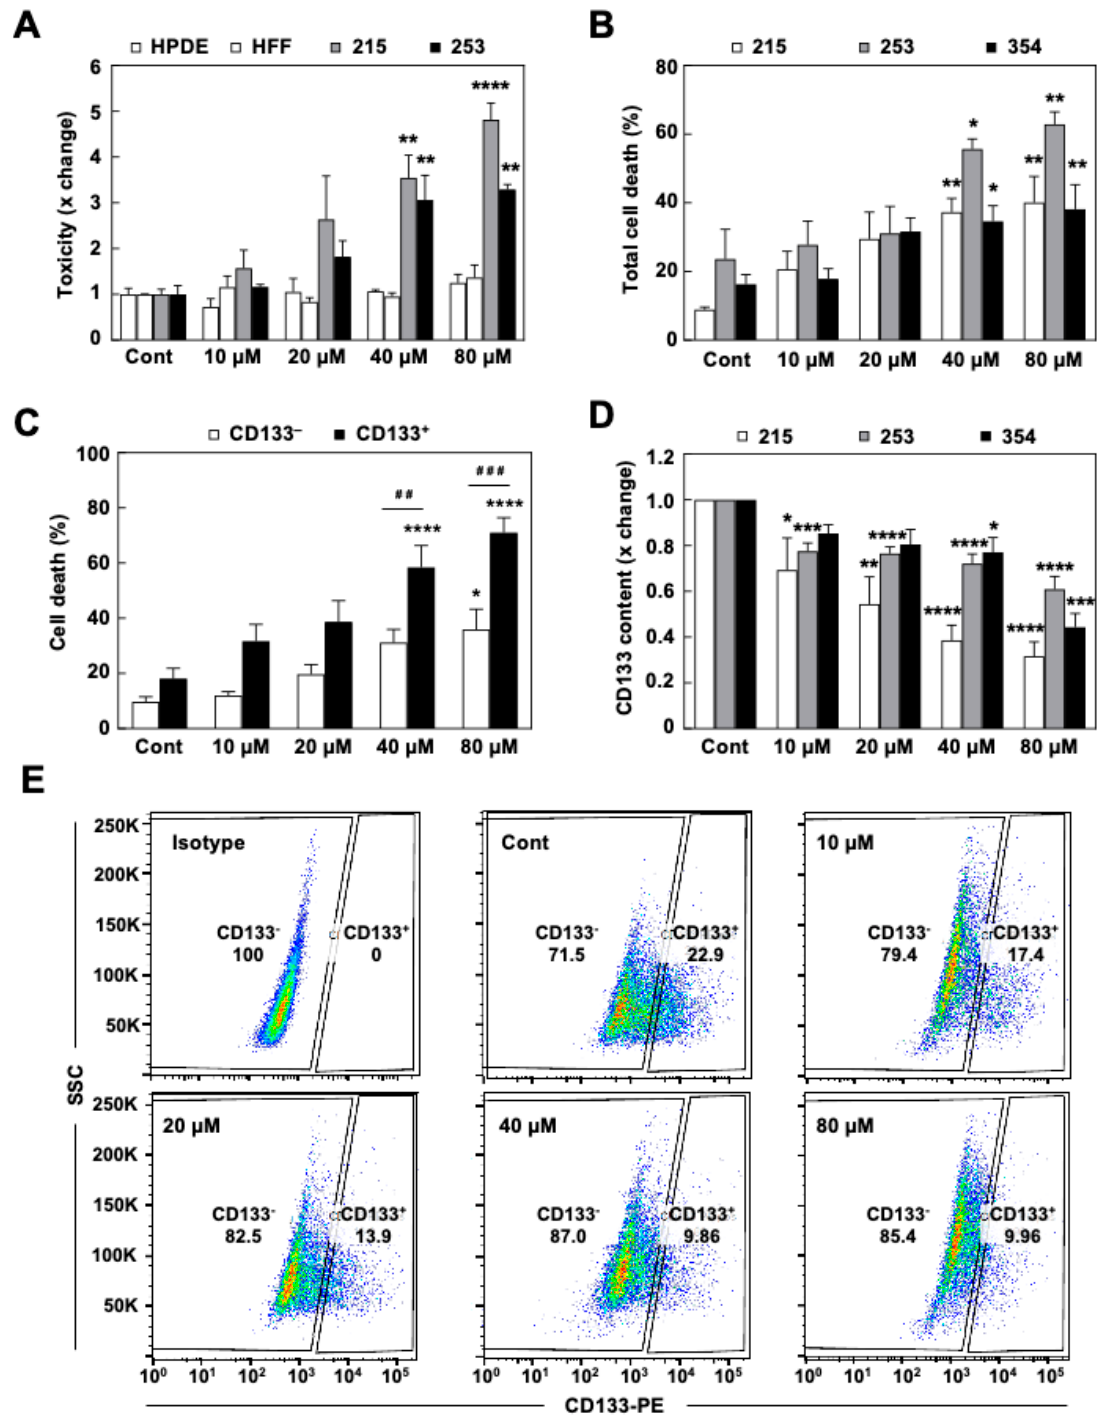
Figure 2. mDivi-1 treatment targets PDAC cancer cells and induces apoptosis in CSCs. ( A ) Cytotoxicity assay in response to mDivi-1 treatment for 72 h using 215 and 253 PDAC cells, non-transformed human pancreatic ductal epithelial cells (HPDE), and human foreskin fibroblasts (HFF). ( B , C ) Total cell death for different PDAC models after 72 h of mDivi-1 treatment, calculated for the entire cancer cell population ( B ) or for CD133 − and CD133 + cells ( C ) after staining for Annexin V-APC and Zombie Violet. ( D ) CD133 content in response to mDivi-1 treatment for 72 h, as evaluated by flow cytometric analysis in three different PDAC models. ( E ) Representative experiment in 253 cells from ( D ) * p < 0.05, ** p < 0.01, *** p < 0.001, **** p < 0.0001 vs. Control; ## p < 0.01, ### p < 0.001 vs. CD133 − cells; ANOVA with Bonferroni’s post-test ( A – C ) or Kruskal–Wallis with Dunn’s post-test ( D ) Data represent averages ± S.E.M. Control is set as 1 for fold